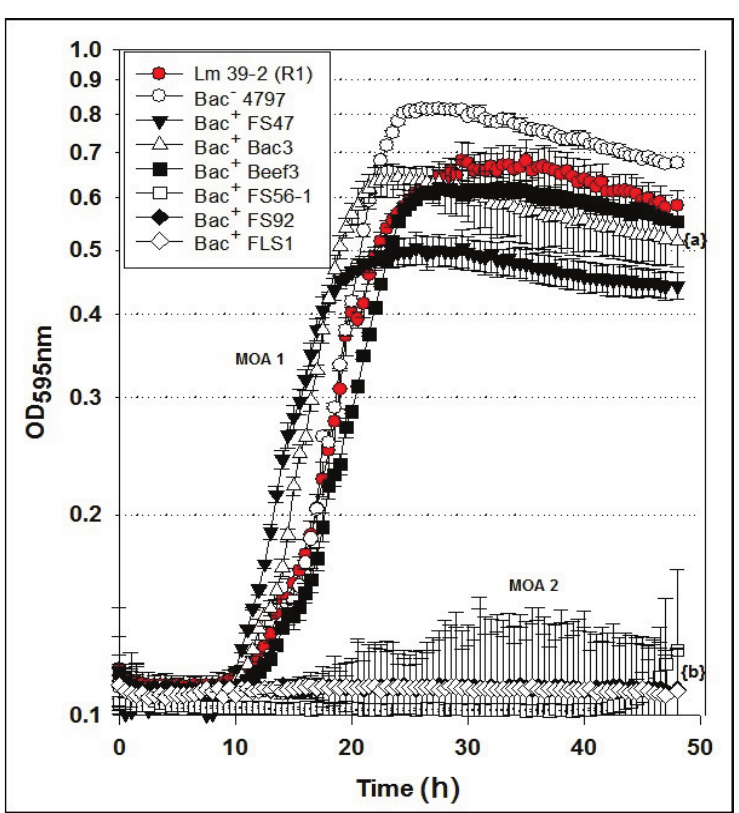
Figure A1. (Figure 5B with error bars) Growth inhibition assay showing the activity of Listeria monocytogenes 39-2 (R1) treated with culture supernatants from: None (R1 Cont.), Lb. delbrueckii 4797-2 (Bac (cid:2) ), Lb. curvatus FS47, P. acidilactici Bac3, Lb. curvatus Beef3, En. faecium FS56-1, En. thailandicus FS92, and Lc. lactis FLS1. Growth inhibition